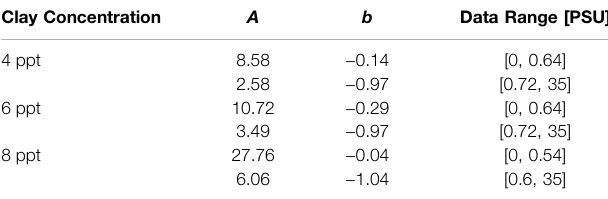
TABLE 3 | Results for the fi t of Equation 8 to the data shown in Figure 7 . Clay Concentration